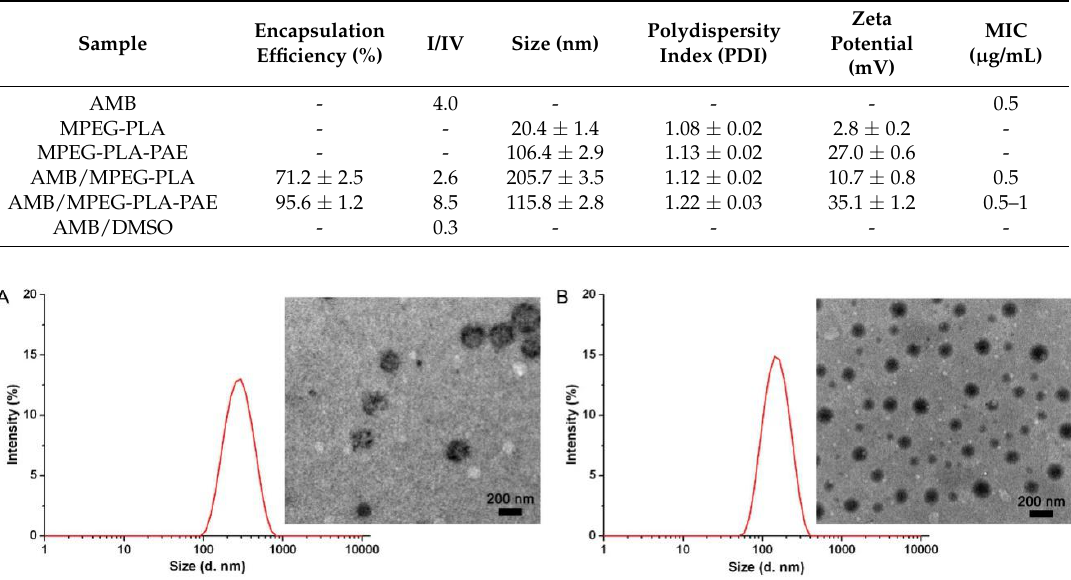
Figure 3. Size distribution and TEM images of ( A ) AMB/MPEG ‐ PLA and ( B ) AMB/MPEG ‐ PLA ‐ PAE. Intensity (%) was achieved from the scattering intensity ratio between the particles and all species in the